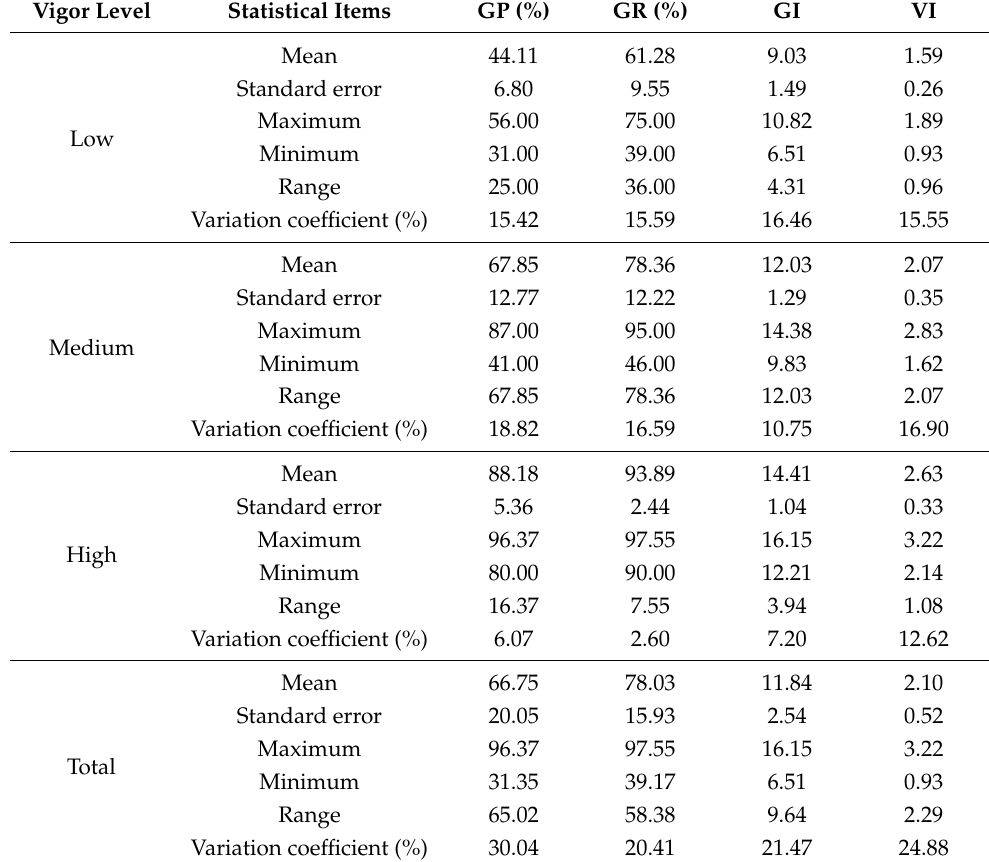
Table 6. Variation in the seed vigor of 12 representative soybean strains with different vigor levels in multiyear and multilocation